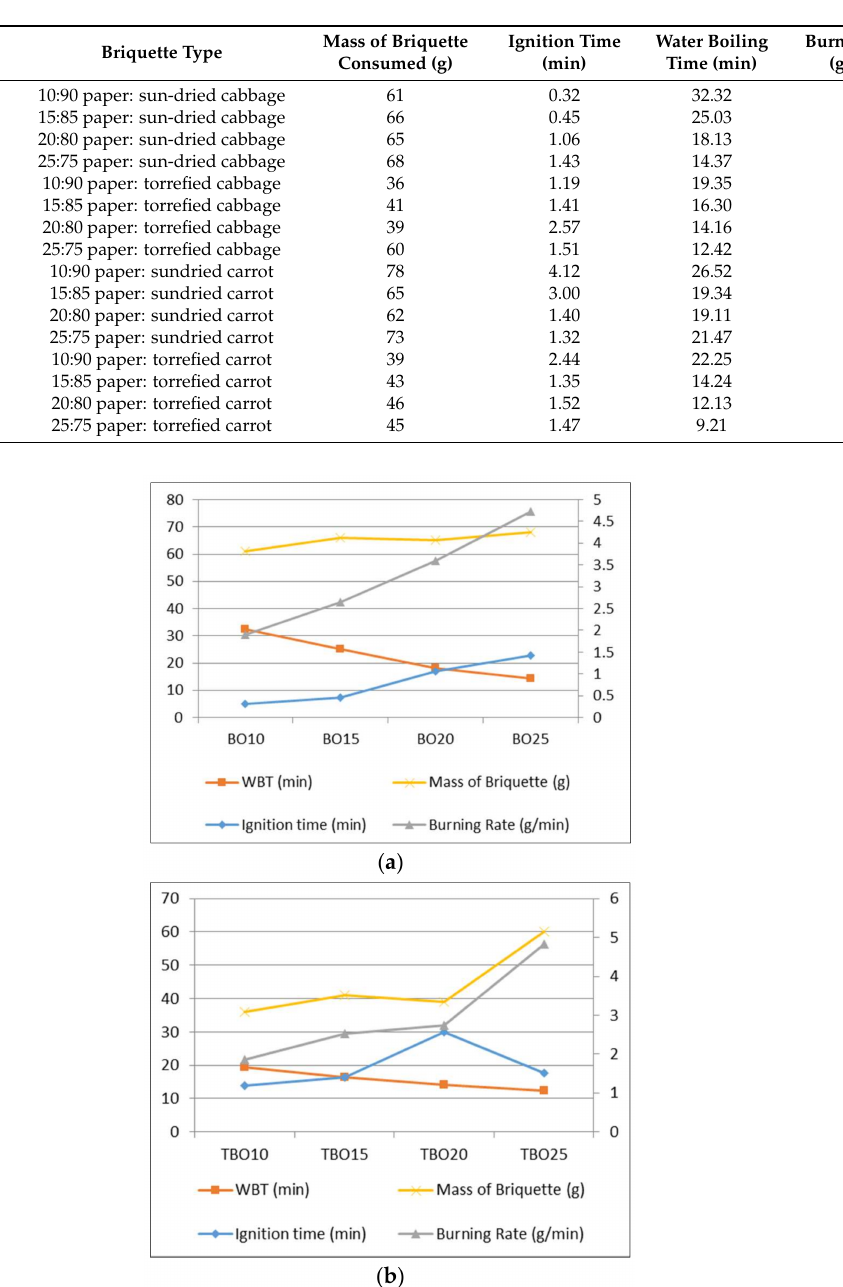
Table 5. Results of water-boiling test of briquettes.